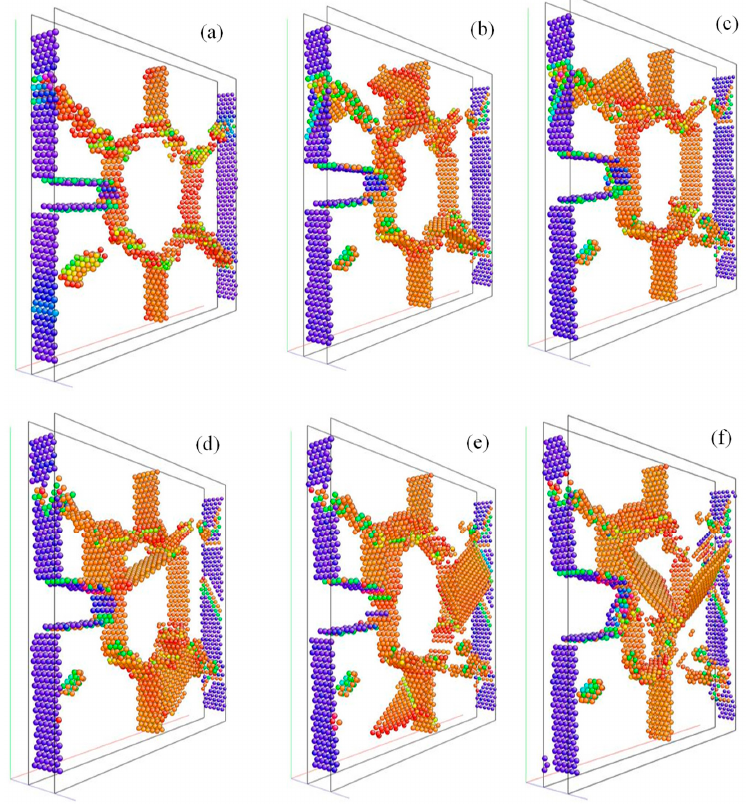
Figure 7. Evolution of atomic configuration in nanoscale polycrystal nickel subjected to early deformation at the strain rate of 2 × 10 8 s − 1 : ( a ) ε = 0; ( b ) ε = 0.06; ( c ) ε = 0.084; ( d ) ε = 0.096; ( e ) ε = 0.12; ( f ) ε = 0.18. (All the configurations are characterized by centrosymmetry parameter (CSP), where stacking faults are companied by Shockley partial dislocations).